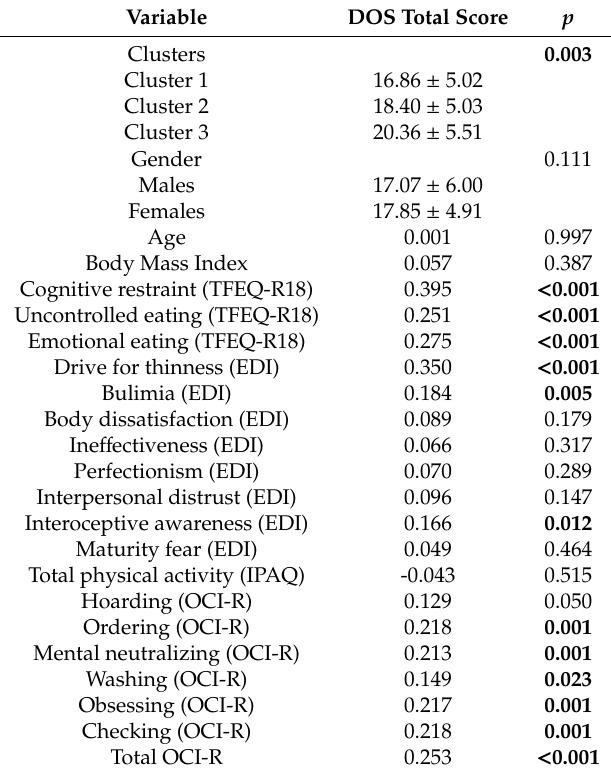
Table 5. Bivariate analysis of factors associated with the DOS total